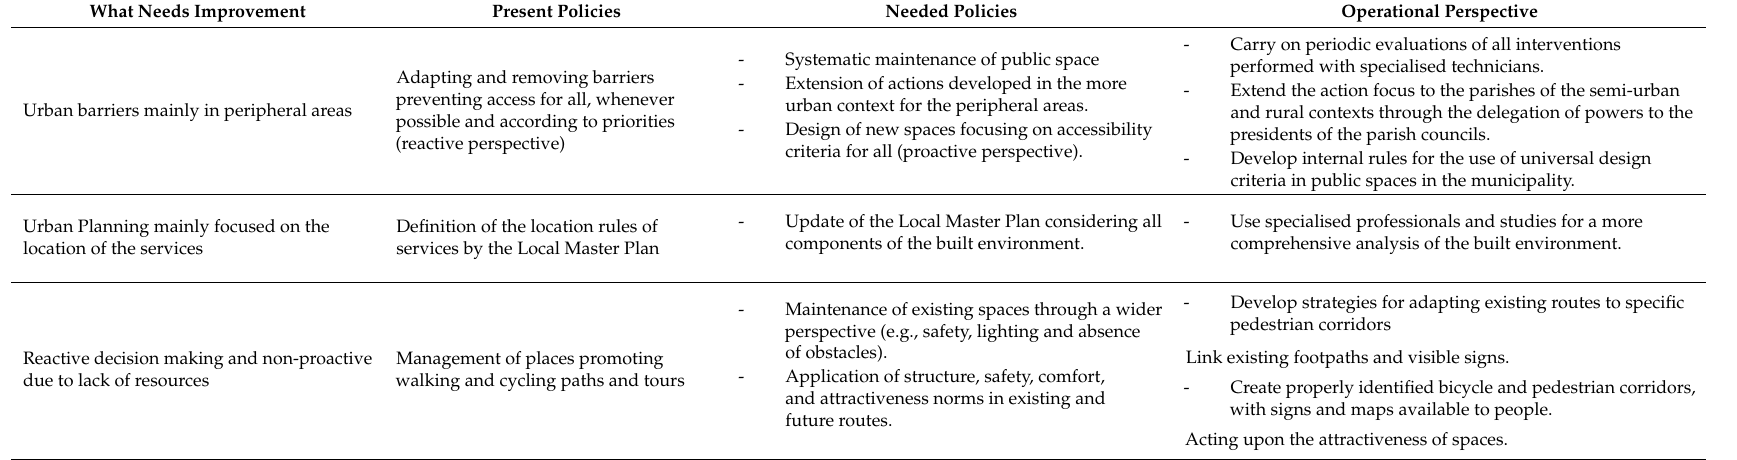
Table 2. Viseu and the built environment: from what is being done to what is needed (Aveiro, Portugal 2016).